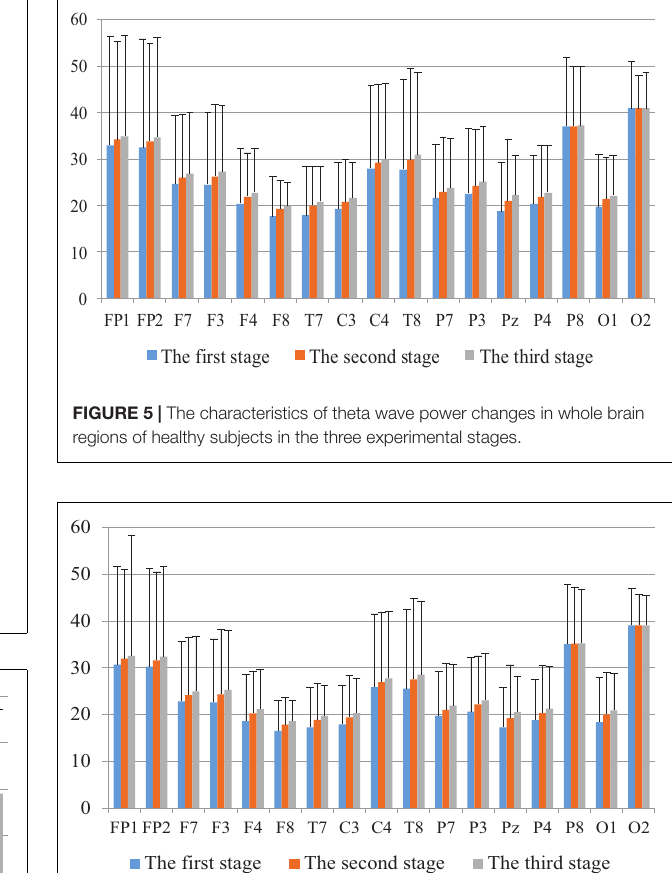
FIGURE 6 | The characteristics of alpha wave power changes in whole brain regions of healthy subjects in the three experimental stages.